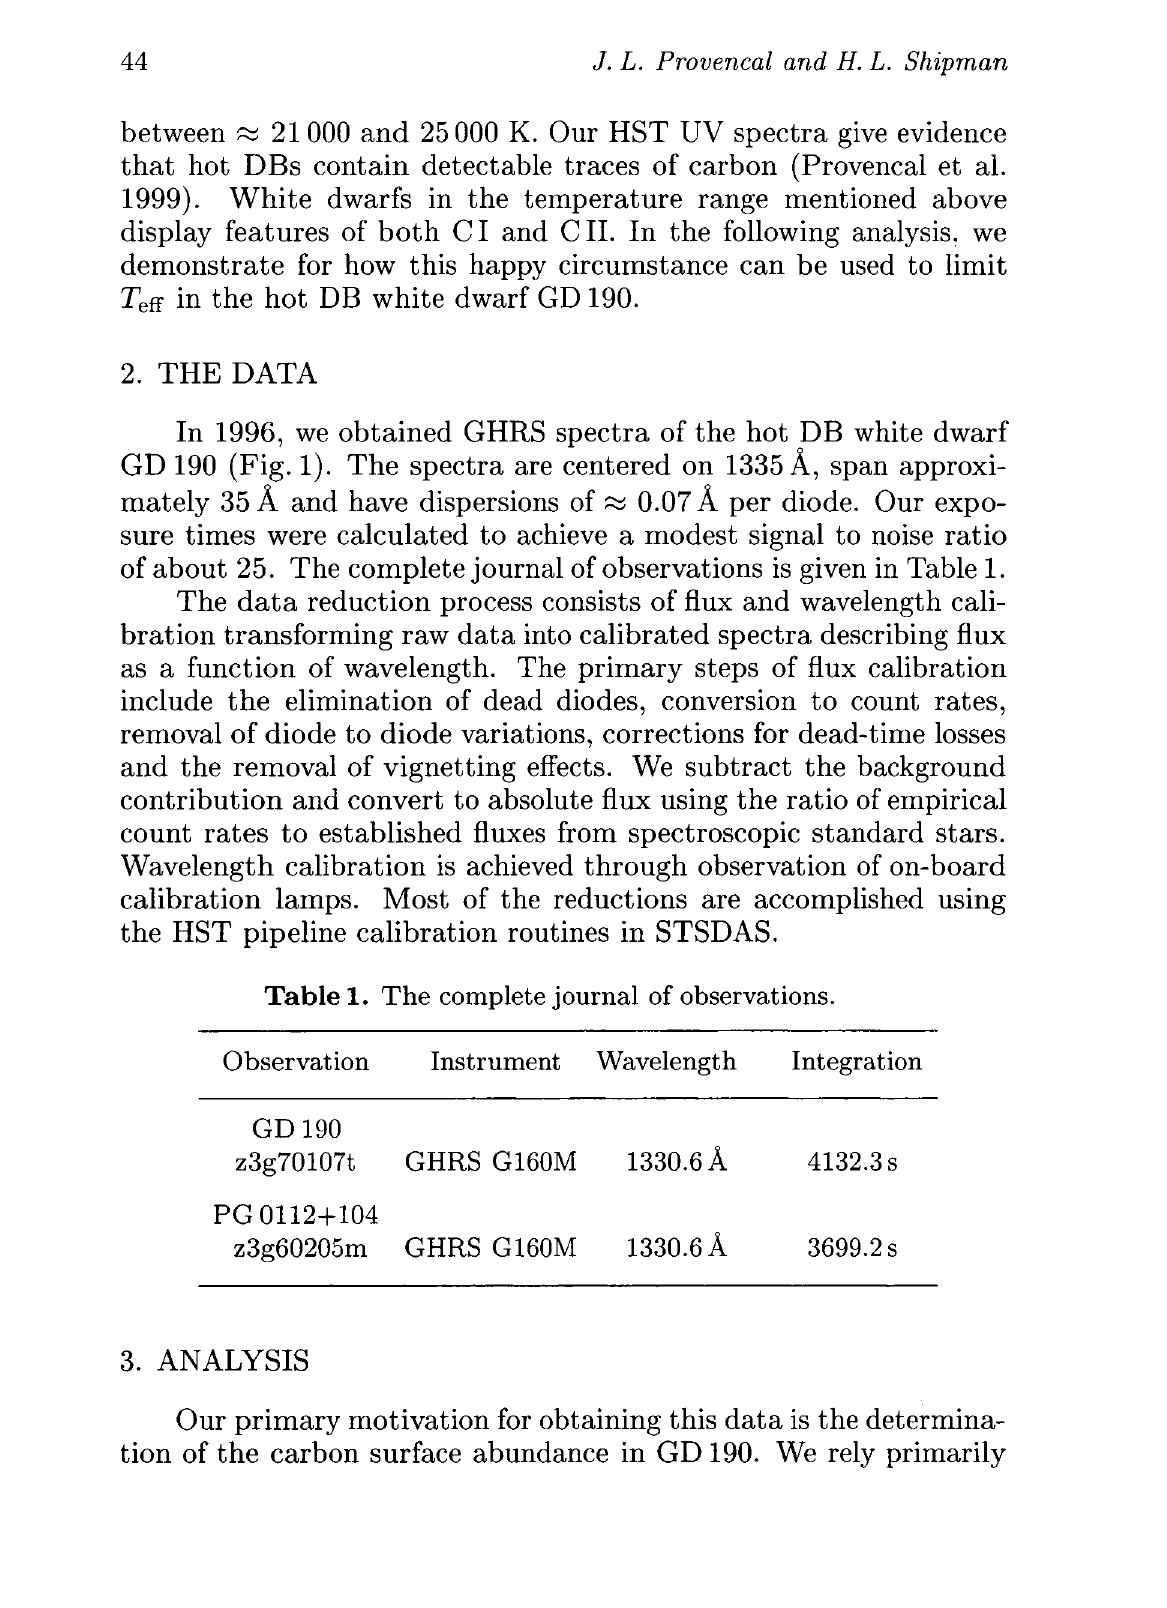
Table 1. The complete journal of